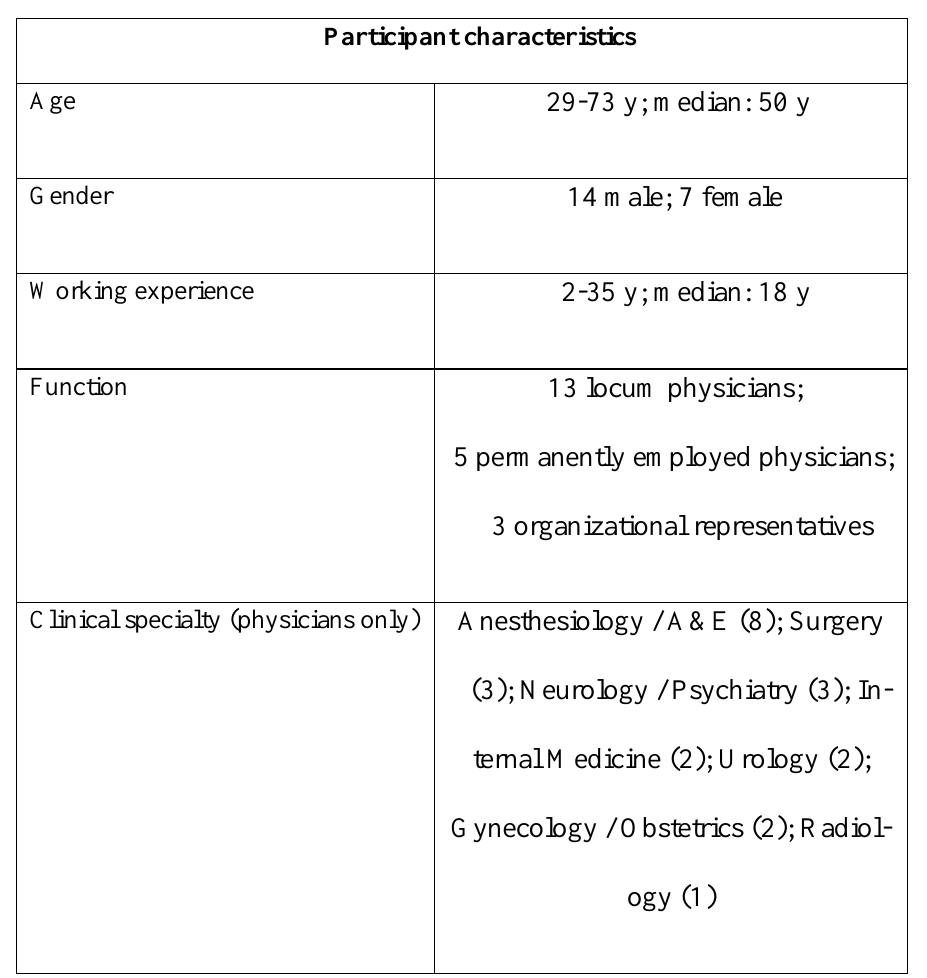
Table 1. Participant